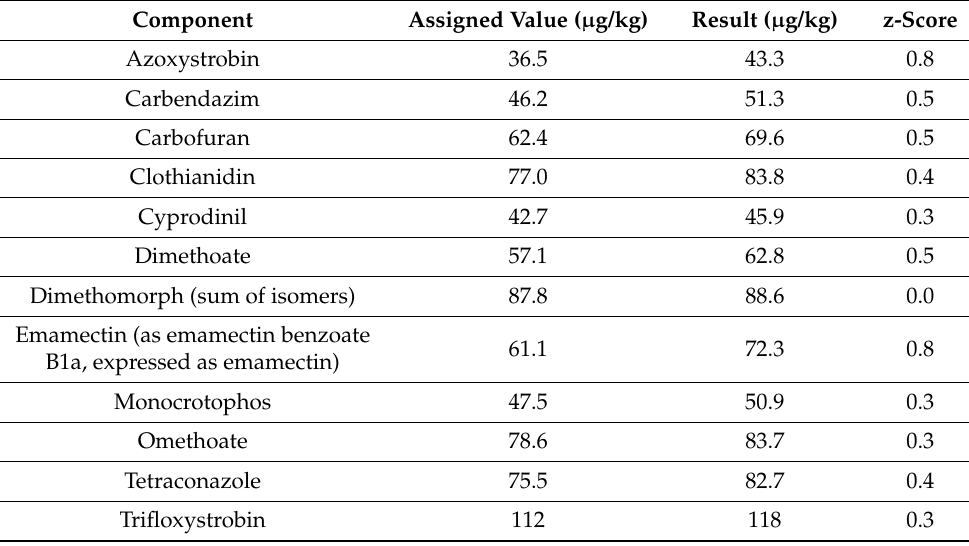
Table 4. Green bean pur é e, proficiency test 19,310 (FAPAS), April 2021.